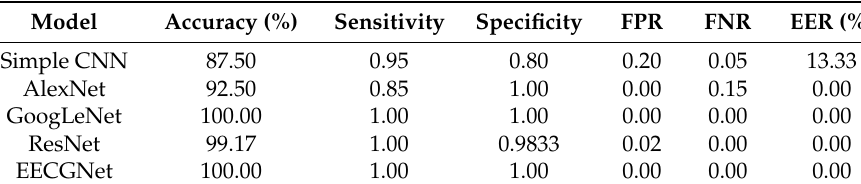
Table 12. Verification performance on PTB-ECG.